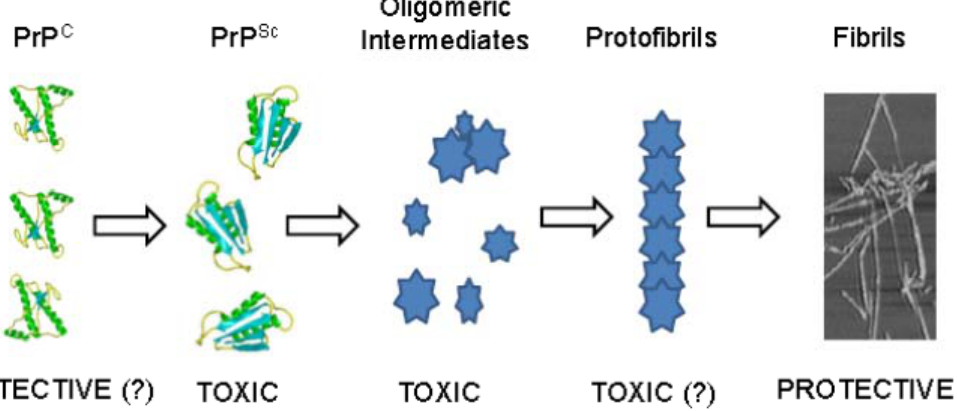
Figure 3. Biological significance of intermediate products during prion aggregation process. Schematic representation of prion aggregation steps. Monomeric PrP Sc , small oligomers or PrP pre-fibrillar structures are believed to be the causative agents of prion-dependent neuronal death. Recent experimental evidence suggests a possible cellular protective role for PrP C and